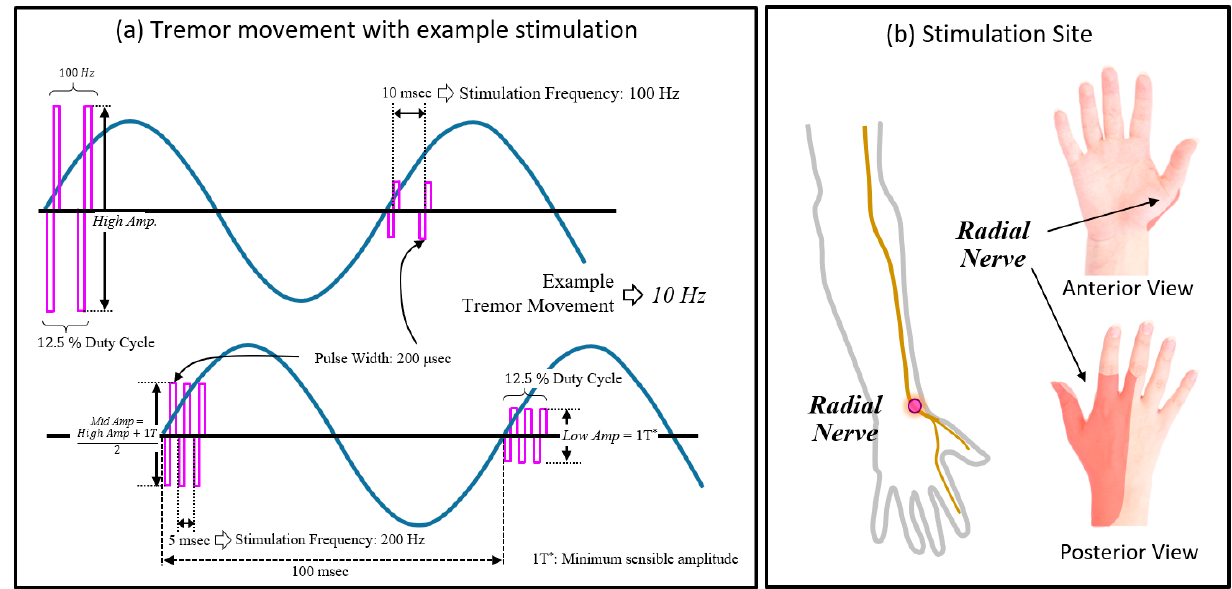
Figure 3. ( a ) Example electrical stimulation with tremor movement for various combinations of stimulation parameters; ( b ) stimulation site: radial nerves with their sensory nerve territories.